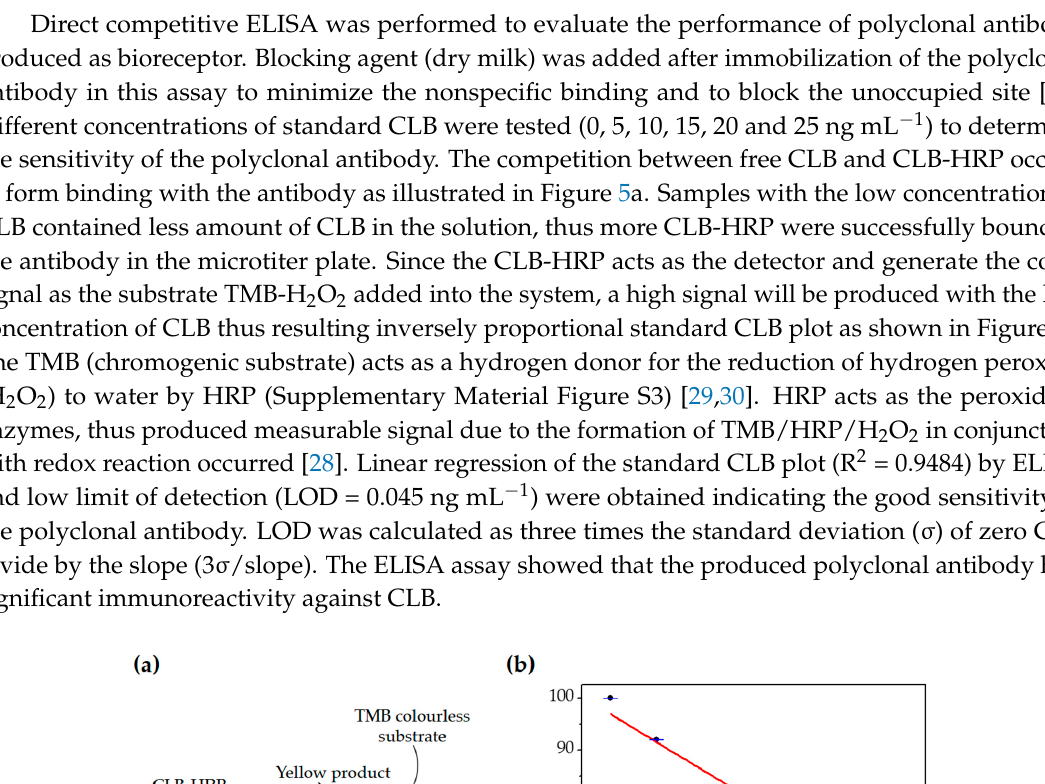
Figure 4. SDS-PAGE pattern of ( a ) protein marker ( b ) commercial IgG from rabbit serum ( c ) purified polyclonal antibody.